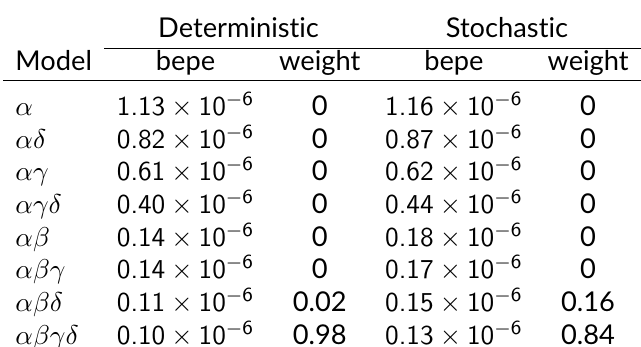
Table 3 – Bootstrap estimate of predictive error (bepe) values and bootstrap model av- erage (booma) weights, based on the data of Rogers, Harris, and Achenbach [24]. Values for the stochastic algorithm are also from that publication. Models are arranged in order of decreasing bepe